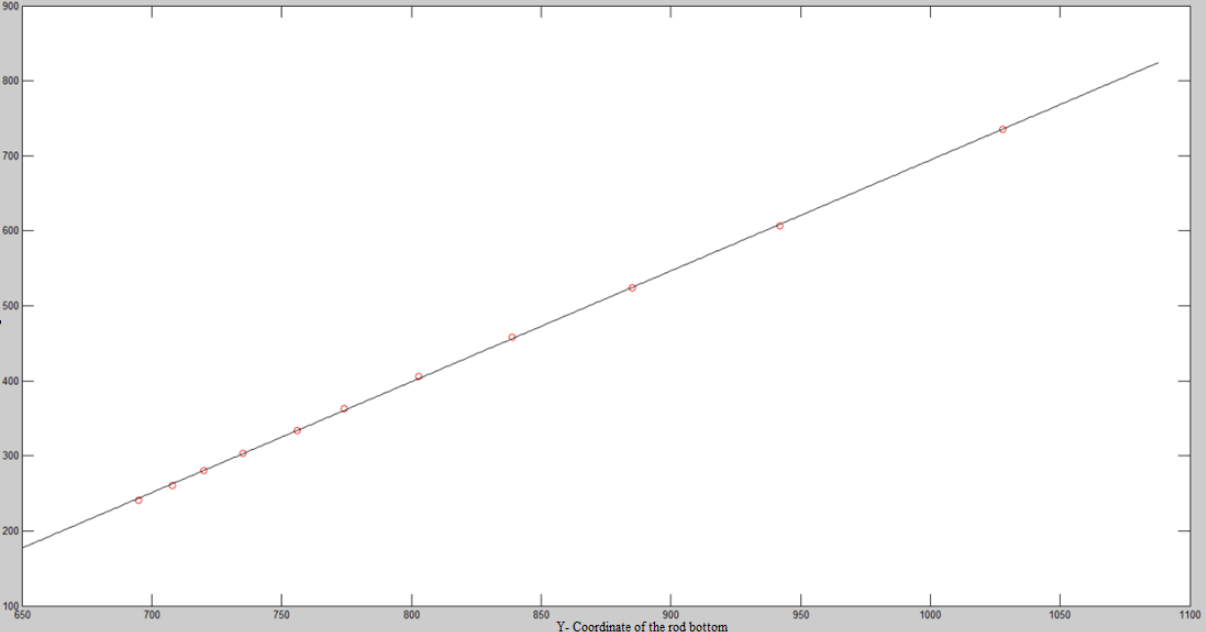
Figure 2. The rod length in the image corresponding to the distance between the rod and